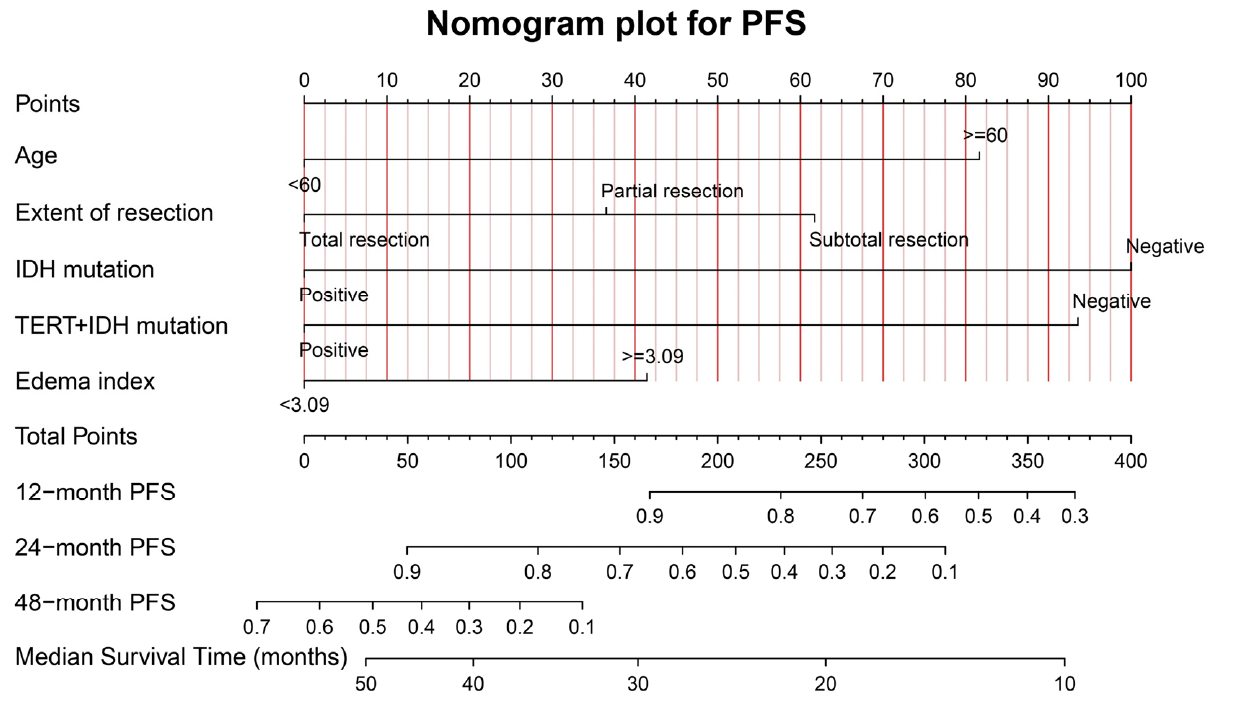
Figure 5. The graphical nomogram model for PFS based on the five significant predictors. The model could provide the predicted PFS at 12, 24, and 48 months, and the median survival time. The calibration curves for PFS at 12, 24, and 48 months for the training (A–C) and validation (D–F) samples, are shown in Supplementary Material Figure S3. The favorable consistency between the predicted and actual survival rates are presented. The C-indexes are 0.79 (95%CI: 0.72–0.86) and 0.68 (95%CI: 0.49–0.87) for the training and validation samples, respectively. The time-dependent AUC curves for the training and validation samples are presented in Supplementary Material Figure S4. The moderate discrimination ability of the novel model is presented according to the AUC curve. Figure 6 shows the graphical nomogram model including the four independent prog- nostic indicators for OS selected utilizing the multivariable COX model, which could predict the patients’ 12-, 24-, and 48-month survival and median survival time. The calibration curves for OS at 12, 24, and 48 months, for the training (A–C) and validation (D–F) samples, are shown in Supplementary Material Figure S5. The favorable consistency between the predicted and actual survival rates are presented. The C-indexes are 0.77 (95%CI: 0.69–0.85) and 0.71 (95%CI: 0.55–0.87) for the training and validation samples, respectively. The time-dependent AUC curves for the training and validation samples are presented in Supplementary Material Figure S6. The moderate discrimination ability of the novel model is presented according to the AUC